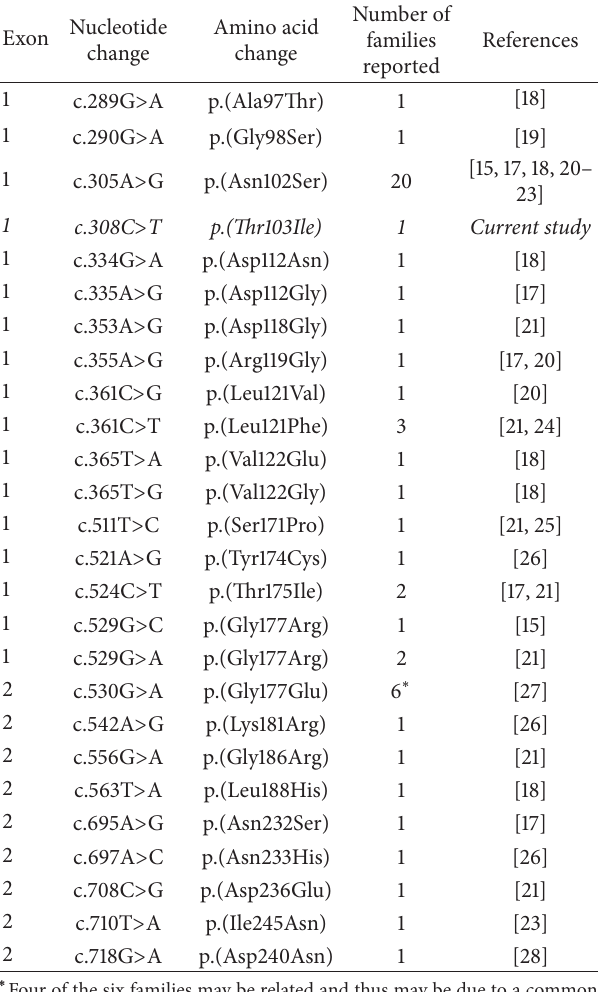
Table 1: Mutations in UBIAD1 associated with Schnyder corneal